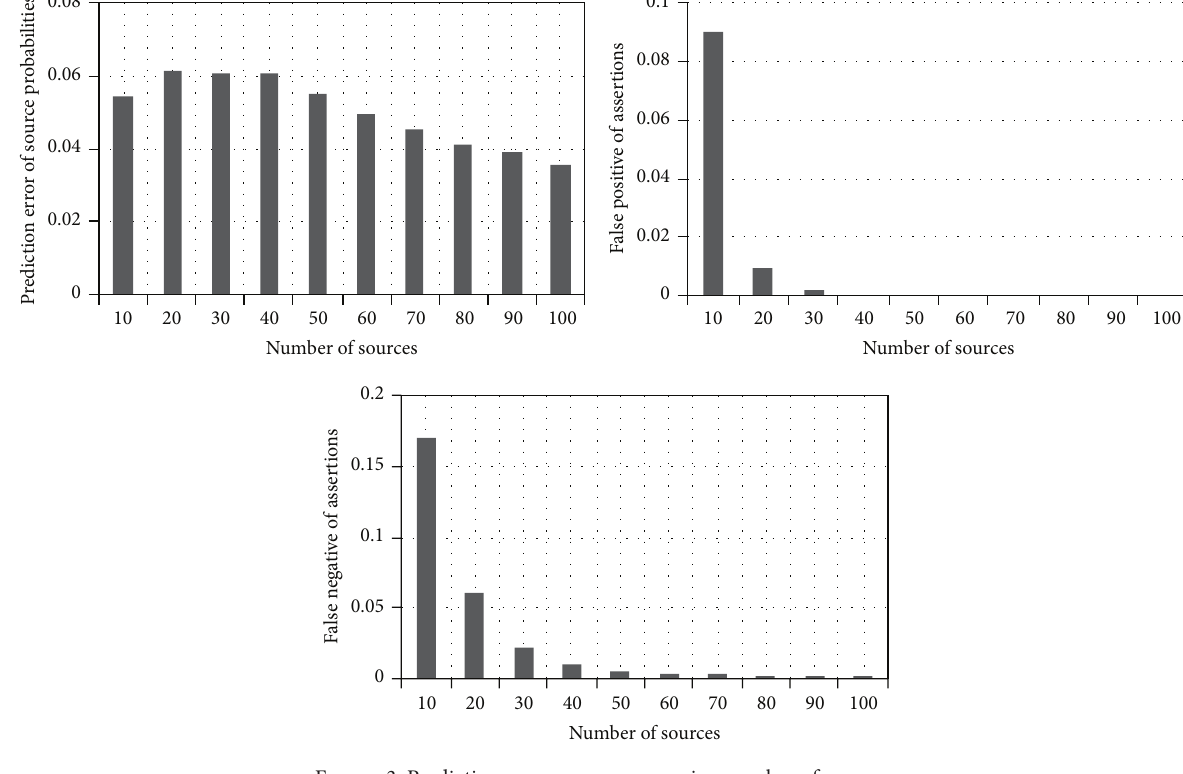
Figure 3: Prediction accuracy versus varying number of sources.